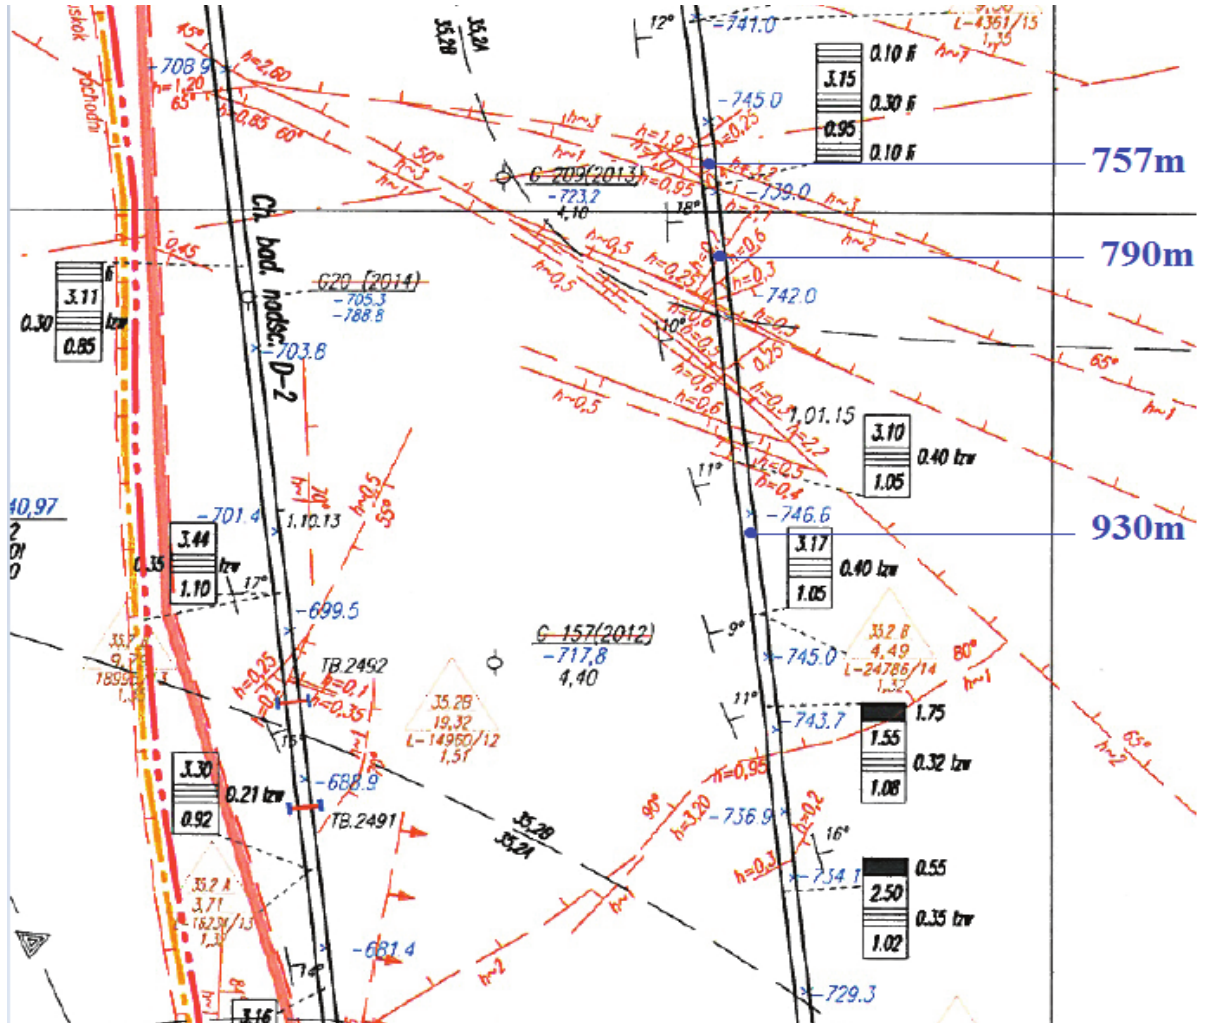
Fig. 2. The mining map of 403/1 seam with analyzed D-2 maingate and measurement